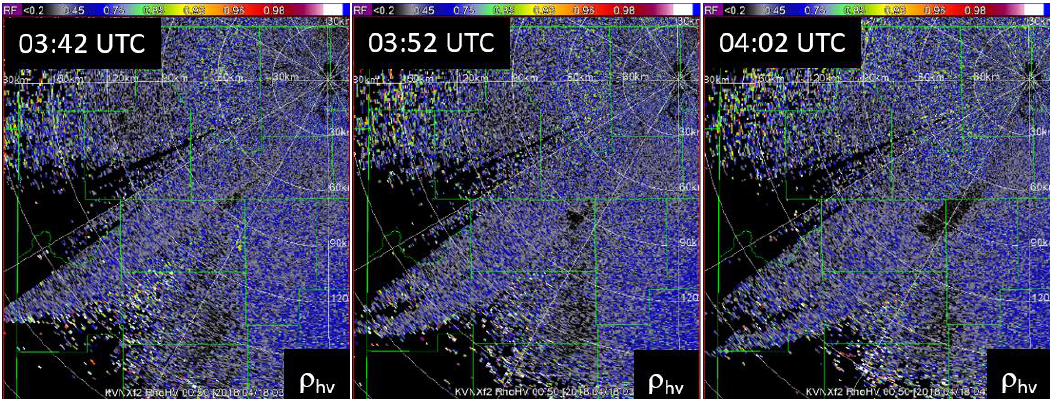
Figure 8. Sequence of satellite images from 3:40 to 3:54 UTC. Oklahoma wildfire, April 18, 2017. The fields of ρ hv at the same times as in Figure 7 are in Figure 9. Just after the frontal passage, the ρ hv decreases (< 0.3).